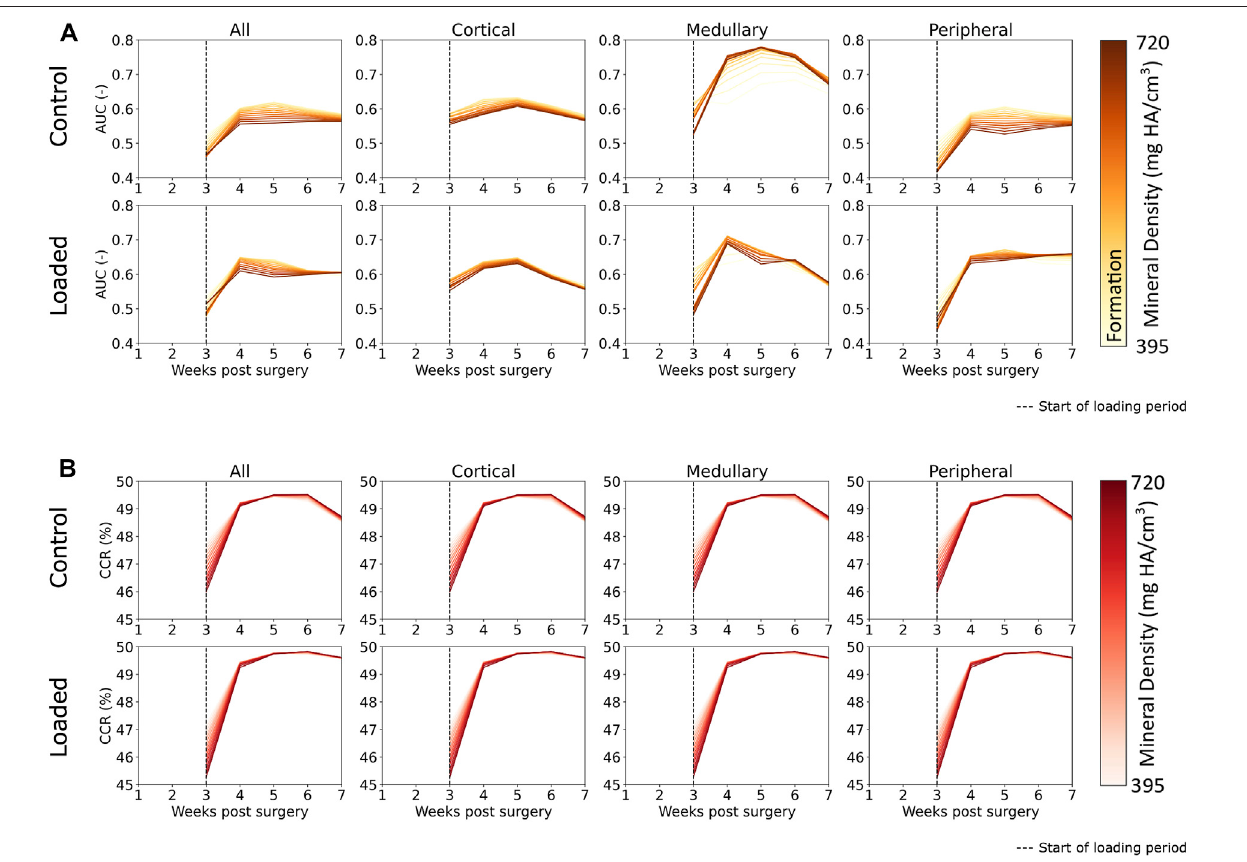
FIGURE 6 | (A) Area under the curve (AUC) for classi fi cation of regions of formation and mineralization based on effective strain values in femur defect regions. All regions displayed effective strain as better than random predictor of formation. Effective strain acts as a better predictor for the mineralization of lowly mineralized tissue forallregionsexceptthemedullaryregioninthecontrolgroup. (B) Correctclassi fi cationrateofformation,resorption,andquiescentvoxelsshowthatextra-physiological loading increases predictability based on effective strain. The decrease of predictability from week 6 to week 7 was observed in the control group but not in the loaded group, and this indicates that the control group is closer to balanced remodeling by the end of the study at week 7 than the loaded group.